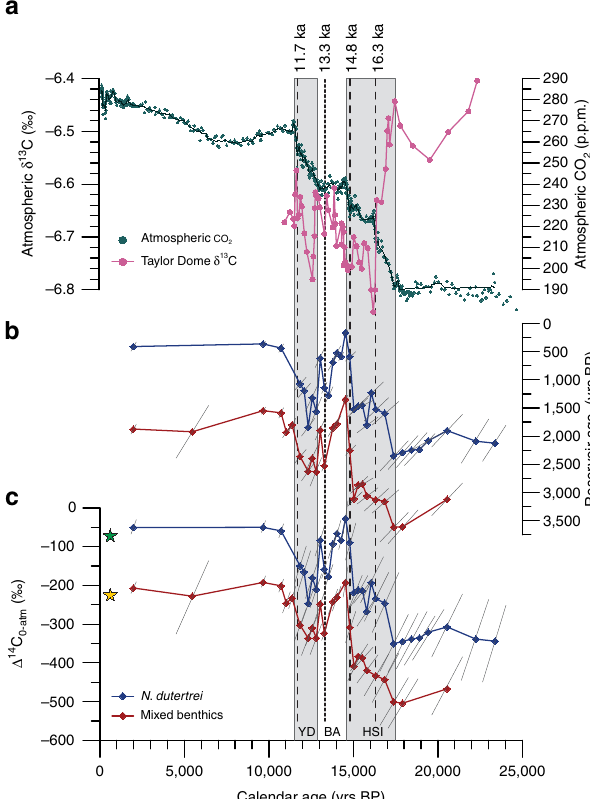
Figure 6 | Foraminifera radiocarbon offsets from the atmosphere over the past 25,000 years. ( a ) Composite atmospheric [CO 2 ] record from Antarctic ice cores 65 and D 13 C from Taylor Glacier, Antarctica 49 . ( b , c ) Reconstructed radiocarbon offsets from the atmosphere displayed in calendar years and as D 14 C 0-atm with the major axis of 1 s error ellipses C displayed. Contemporary D 14 C from GLODAP 58 is shown for thermocline 14 depths (green star, (cid:2) 85 % ) and for 2.7km (yellow star, (cid:2) 220 % ). Three centennial increases in the WDC atmospheric CO 2 record occur at 16.3, 14.8 and 11.7ka (dashed line) 46 . There is an EEP equivalent at both thermocline and deep water depths for the 14.8ka event, while a possible 16.3ka event corresponds with only an increase in thermocline ventilation. Our records do not have sufficient resolution at 11.7ka to capture ventilation changes associated with this century- long CO 2 increases. An additional ventilation event is recorded in TR163-23 in the late BA (dotted line). WDC, West Antarctic Ice Sheet Divide Ice Core.